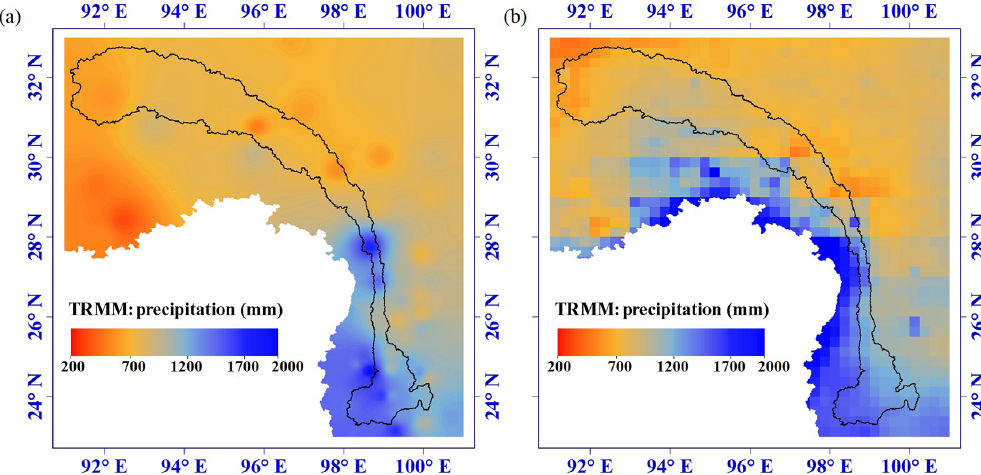
Figure 10. Spatial distribution of mean annual precipitation of 2003–2012 estimated by (a) IDW and (b) TRMM.